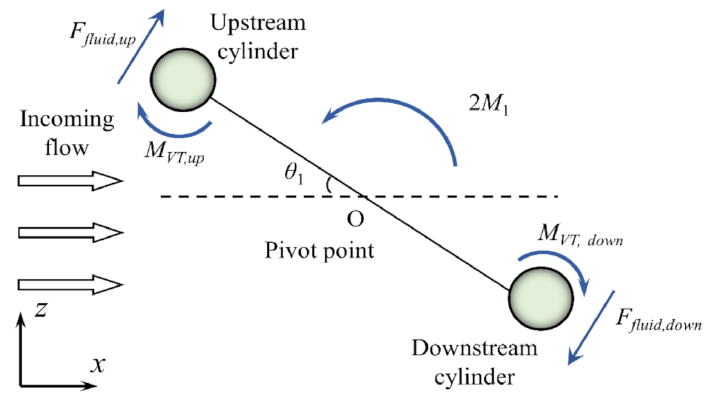
Figure 2. Force analysis of pendulum